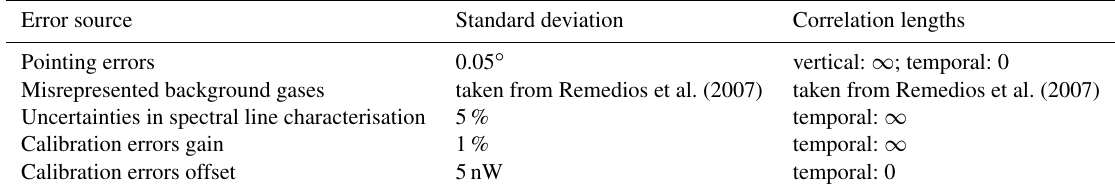
Table 2. Systematic error sources included in the retrieval diagnostics with respective standard deviations and correlation lengths. Error source Standard deviation Correlation lengths Pointing errors 0.05 ◦ vertical: ∞ ; temporal: 0 Misrepresented background gases taken from Remedios et al. (2007) taken from Remedios et al. (2007) Uncertainties in spectral line characterisation 5% Calibration errors gain 1% Calibration errors offset 5nW